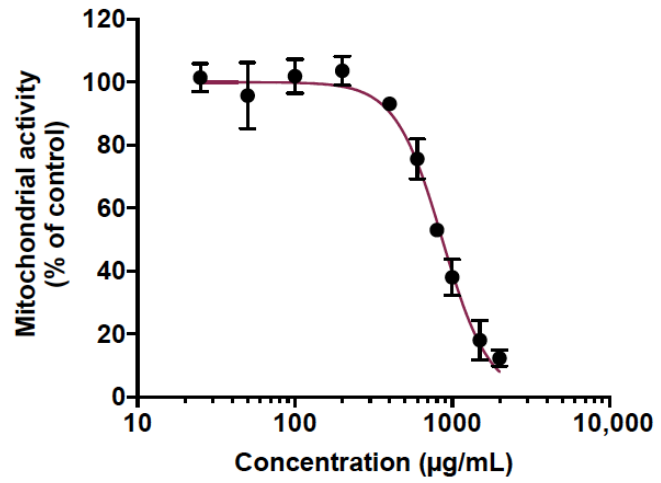
Figure 1. Determination of the maximal non-toxic concentration (MNTC) of cranberry pomace extract on human A549 cell line. A549 cells were grown in the presence of various concentrations of CP extract (25 to 2000 µ g/mL) for 48 h. The metabolic activity was assessed by MTT assay. Results presented are means ± SD of three independent experiments and are expressed as relative values to the vehicle control.